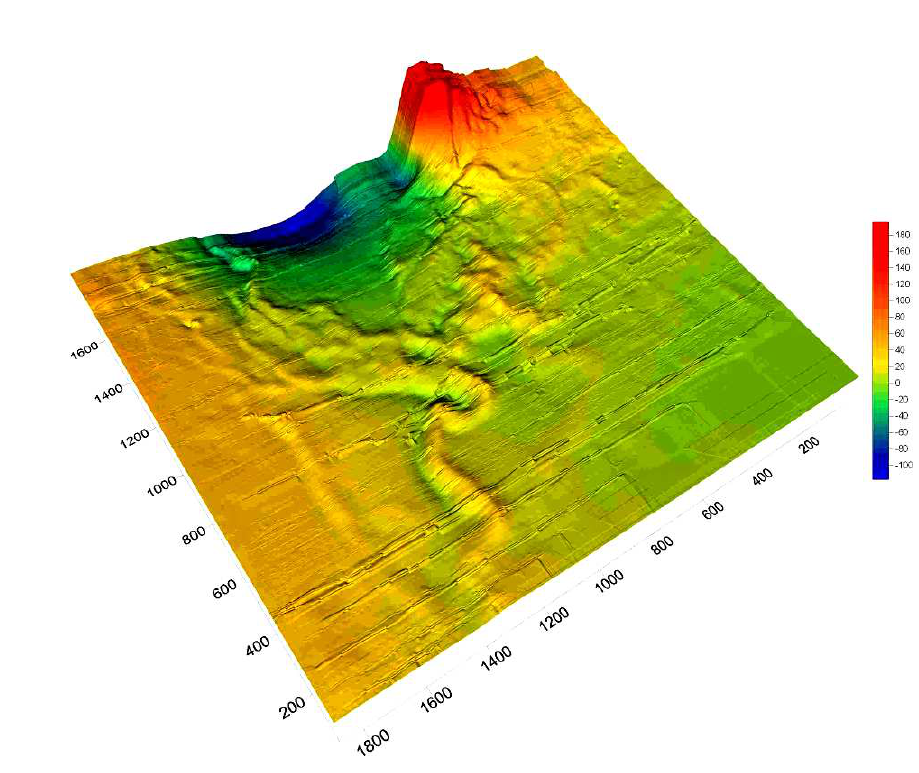
Figure 7. 3D magnetic map of all survey area. Color scale is in nT and grid is in